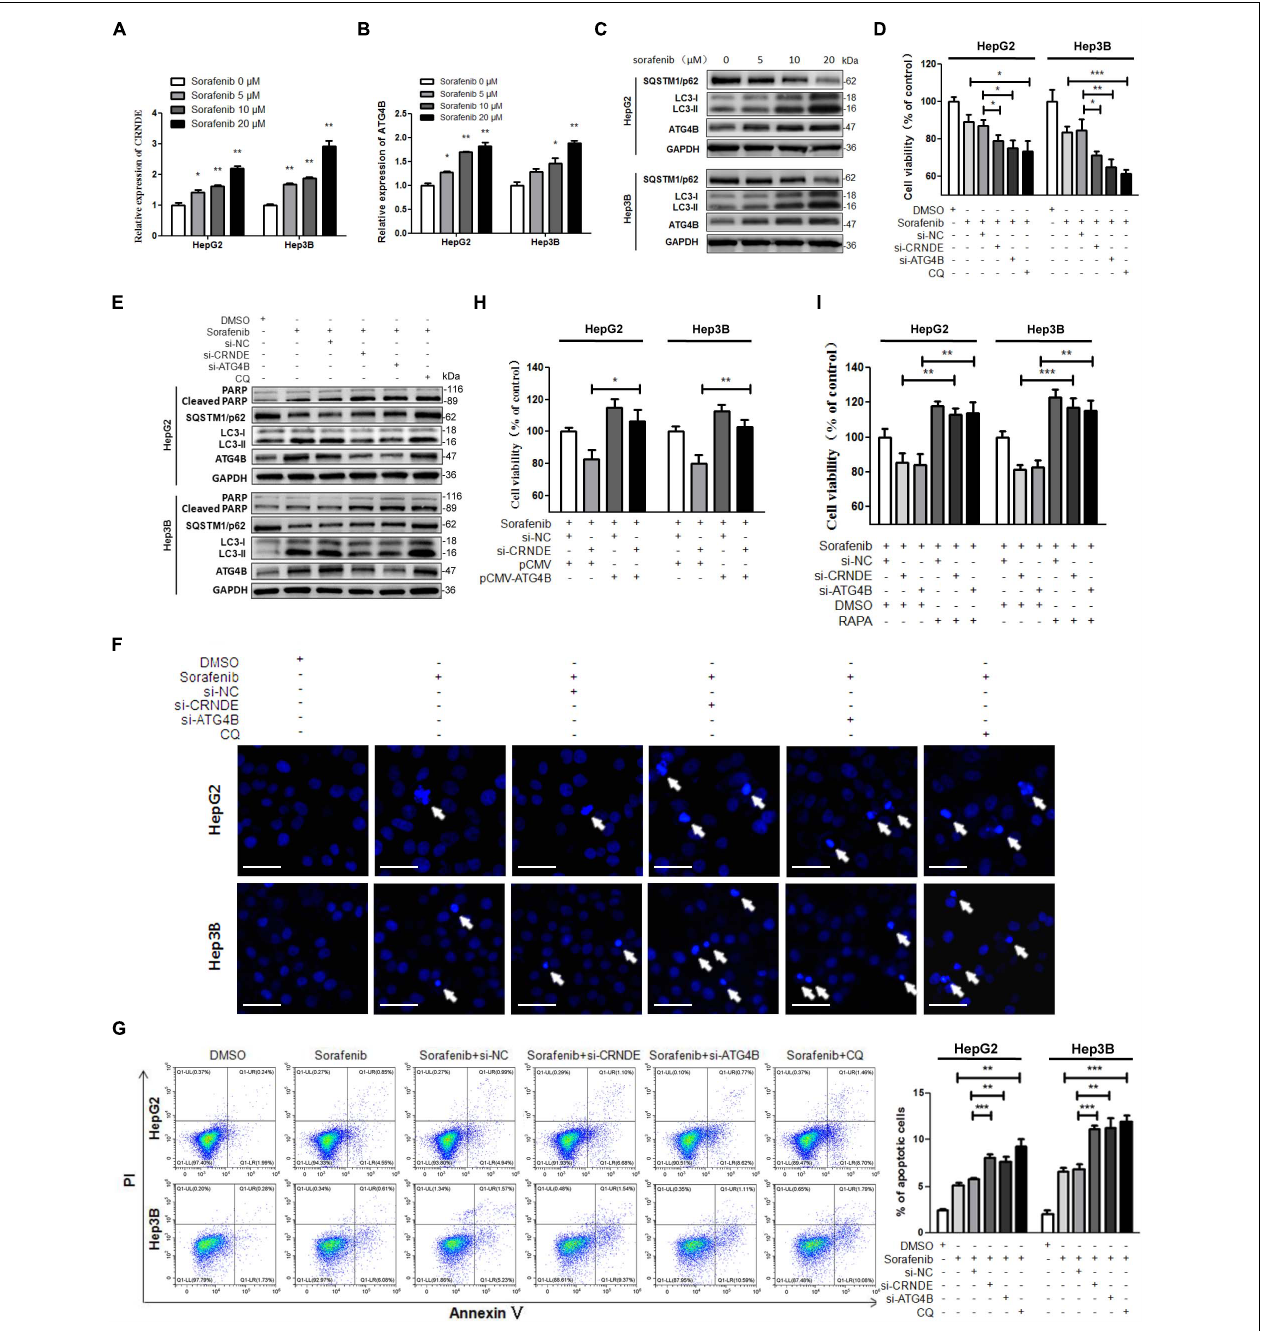
FIGURE 6 | CRNDE /ATG4B/autophagy axis attenuates the sensitivity of sorafenib in HCC cells. (A–C) HepG2 and Hep3B cells were treated with various concentrations of sorafenib for 24 h. Then the levels of CRNDE and ATG4B mRNA were determined by qPCR (A,B) , and the levels of SQSTM1/p62, LC3, and ATG4B protein were measured by Western blot (C) . (D,E) HepG2 and Hep3B cells were transfected with si-CRNDE, si-ATG4B (or si-NC), or treated with 20 µ M chloroquine (CQ) (or vehicle control DMSO) for 12 h, and then treated with 10 µ M sorafenib for 24 h. Subsequently, the cell viability was analyzed by CCK-8 assay (D) , and the levels of cleaved PARP, SQSTM1/p62, LC3, and ATG4B were tested by Western blot (E) . (F) After treatment as in panels (D,E) , the cells were stained with Hoechst 33258, and then observed under a fluorescence microscope (scale bar: 20 µ m; white arrows indicate the apoptotic cells). (G) After treatment as in panels (D,E) , the cells were stained with annexin V-FITC/PI, and then the cell apoptosis was assayed by flow cytometry. (H) After co-transfected with si-CRNDE (or si-NC) and pCMV-ATG4B (or pCMV) for 12 h, HepG2 and Hep3B cells were treated with 10 µ M sorafenib for 24 h, and then the cell viability was detected by CCK-8 assay. (I) HepG2 and Hep3B cells were transfected with si-CRNDE, si-ATG4B (or si-NC) for 12 h, followed by the co-treatment with 0.1 µ M rapamycin (RAPA) and 10 µ M sorafenib (or vehicle control) for 24 h. Subsequently, the cell viability was examined by CCK-8 assay. si-CRNDE: the siRNA for CRNDE; si-ATG4B, si-NC, pCMV-ATG4B and pCMV were the same as the description in Figure 2 ; ns, no significance; * P < 0.05; ** P < 0.01; *** P < 0.001.